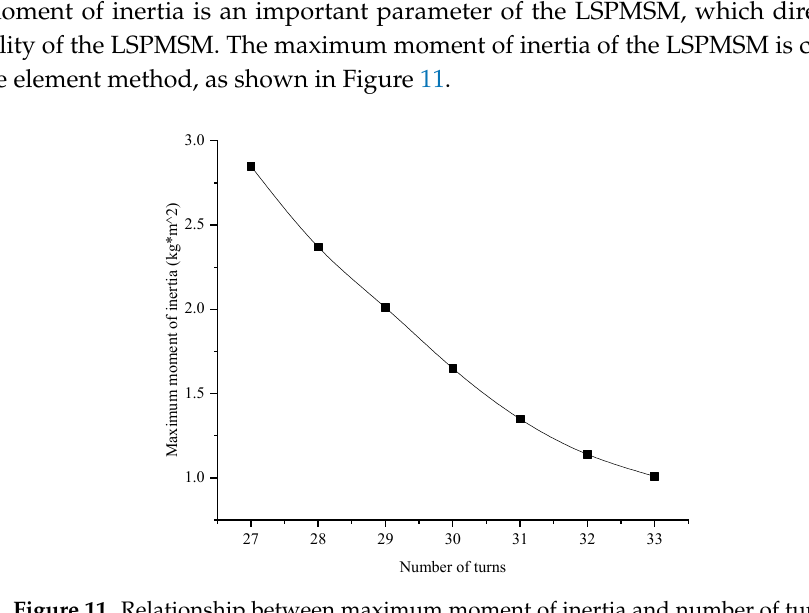
Figure 11. Relationship between maximum moment of inertia and number of turns.